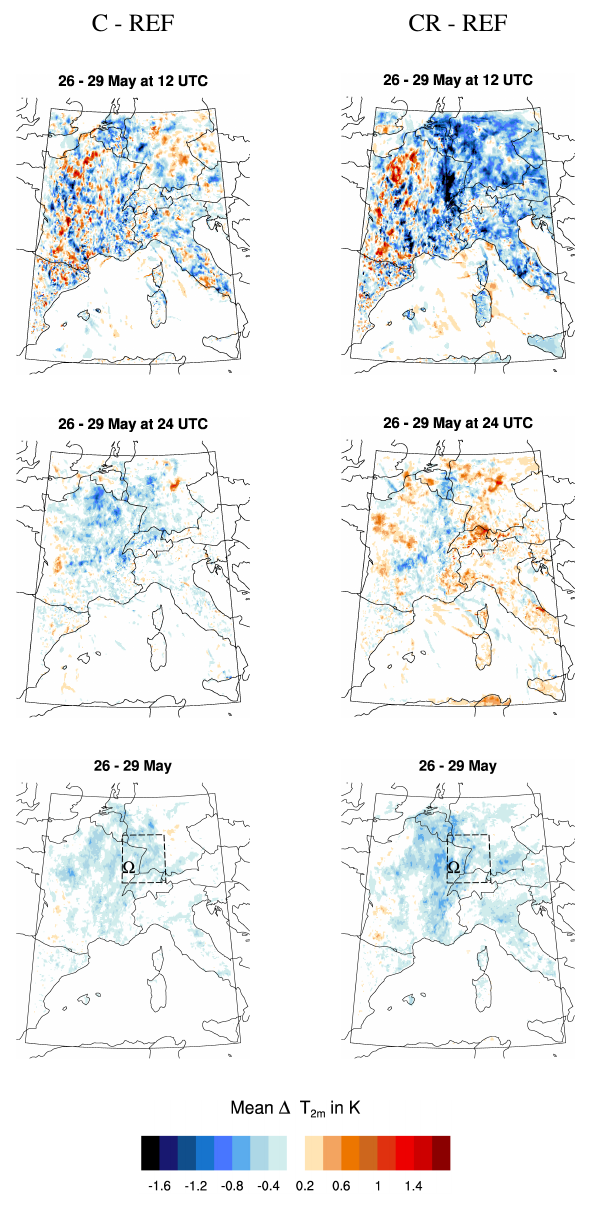
Fig. 14. Mean difference in T 2m at 12:00 UTC and 24:00 UTC from 26–29 May 2008 and total mean difference in T 2m from 26–29 May 2008 between simulation C and REF (left column) and simulation CR and REF (right column).